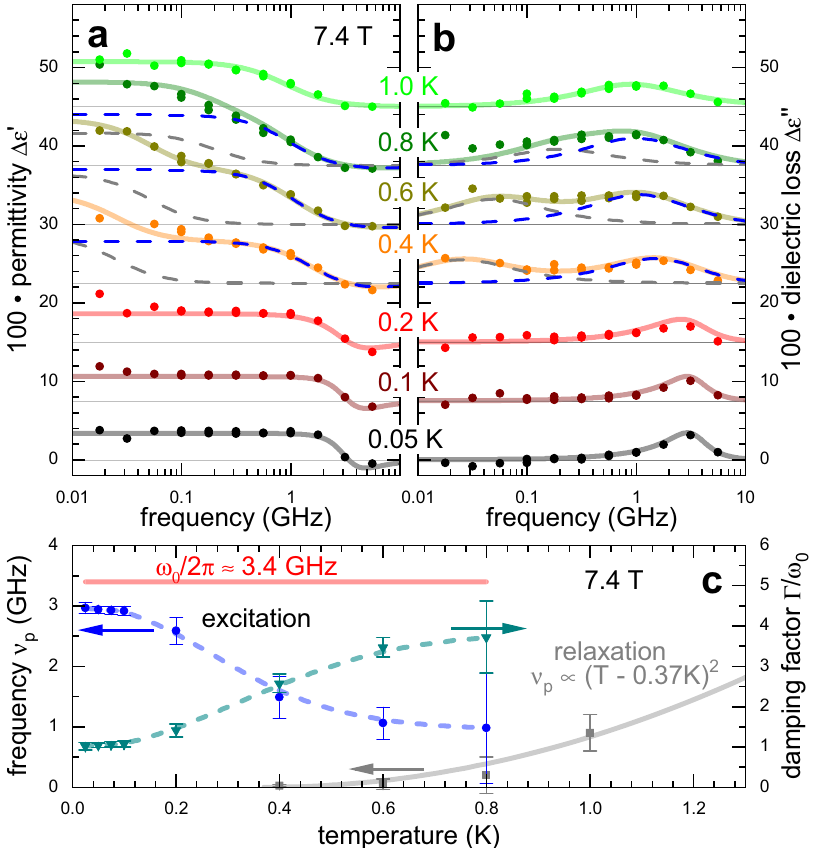
Fig. 4 Dynamics at low temperatures. Measured spectra (points) of the complex permittivity Δ ε * ( ν ) at H ≈ H c with fi ts of Equation (2) (lines) are shown in a for the real part, Δ ε 0 , and the imaginary part, the dielectric loss Δ ε ″ , in b as a function of the frequency ν . The fi tted peak frequencies of the maxima in Δ ε ″ are shown in c for both the relaxation (gray squares) and the emergent excitation (blue circles) on the left scale with the corresponding damping factor for the excitation (triangles) on the right scale. The error bars in c correspond to the root mean squared error that was obtained when fi tting the spectra with Equation